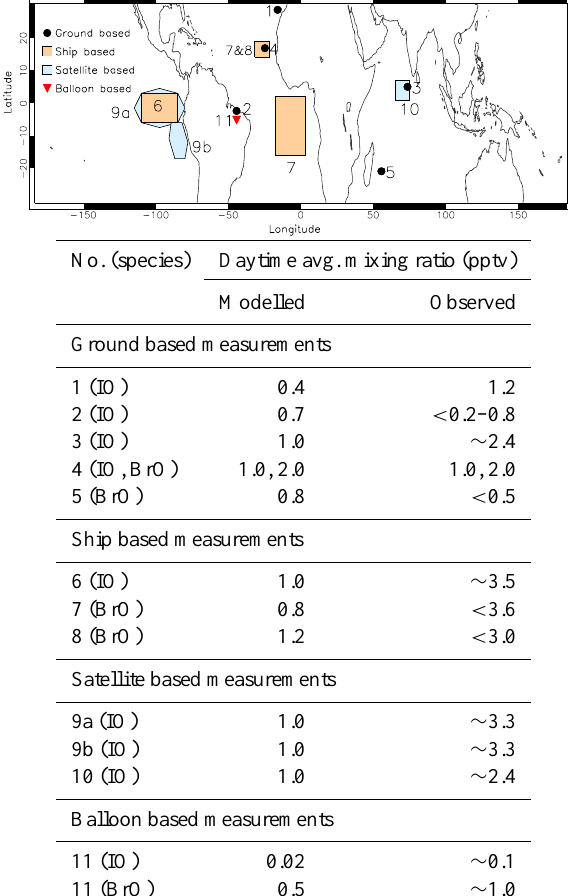
Fig. 2. Mixing ratios of iodine oxide (IO) and bromine oxide (BrO) in the TMBL. Observations were compiled from ground-, ship-, satellite- and balloon-based platforms. Modelled mixing ratios sim- ulated by CAM-Chem correspond to averages for the same areas and months as the observations. Daytime represents sunlit hours.